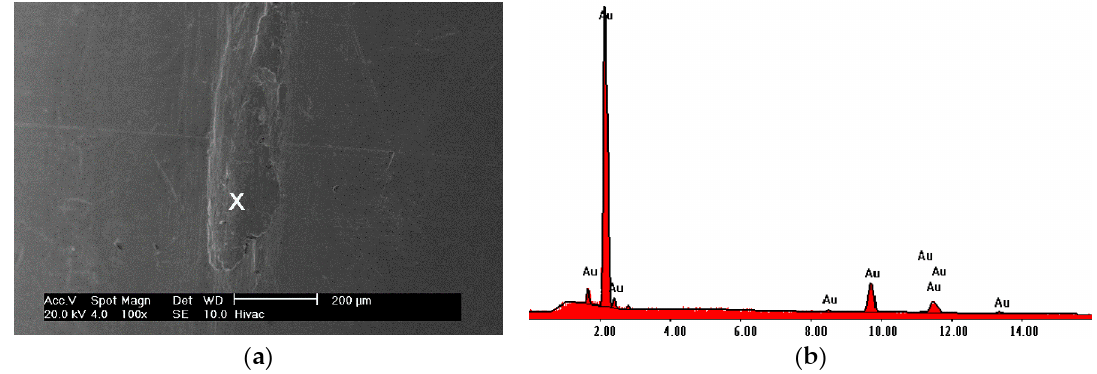
Figure 9. ( a ) Electron microscope portrayal of appositions of gold by the secondary crowns on the primary crown. This is an example from series C x ‐ marking the area examined by means of X ‐ ray spectroscopy (Energy Dispersive X ‐ Ray (EDX)) analysis; ( b ) Result of the EDX analysis of the area marked in Figure 9a. Gold was exclusively detected.